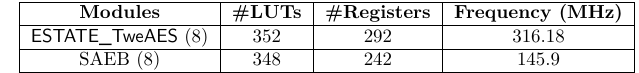
Table 9: 8-bit Implementation Results (Virtex 7) of ESTATE_TweAES and SAEB